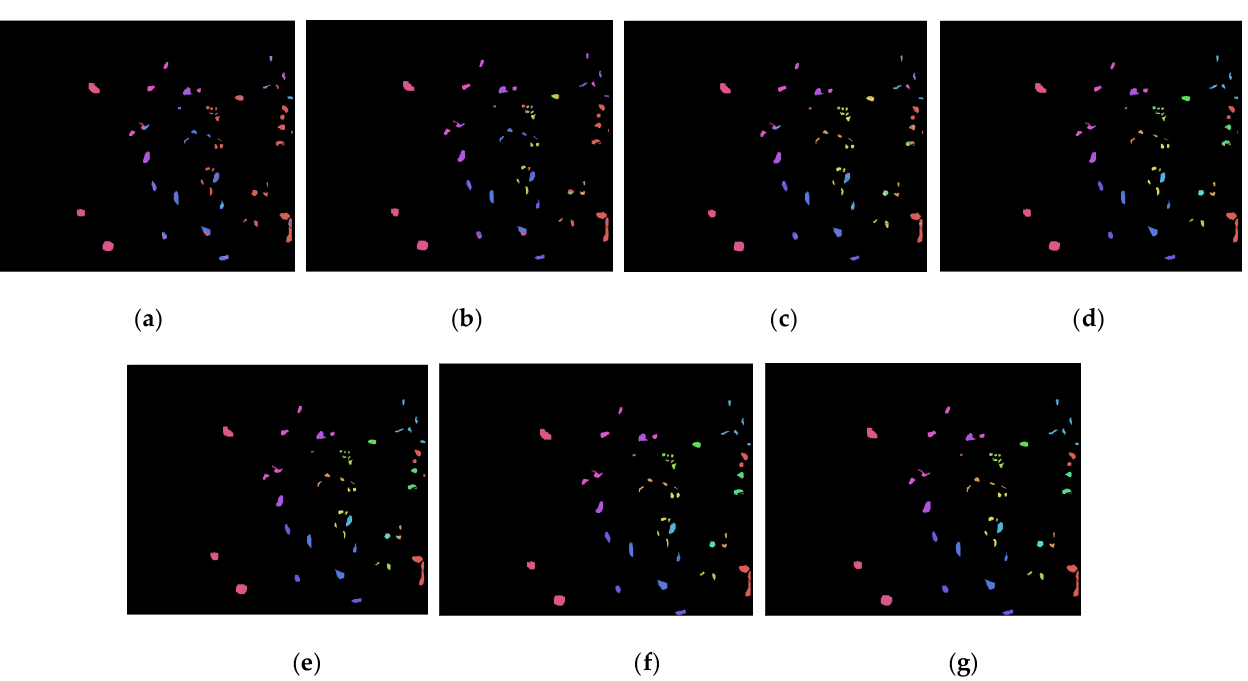
Figure 15. ( a – g ) Classification map of PCA, SVM, 2D-CNN, 3D-CNN, RES-3D, SSRN, and proposed on KSC dataset.